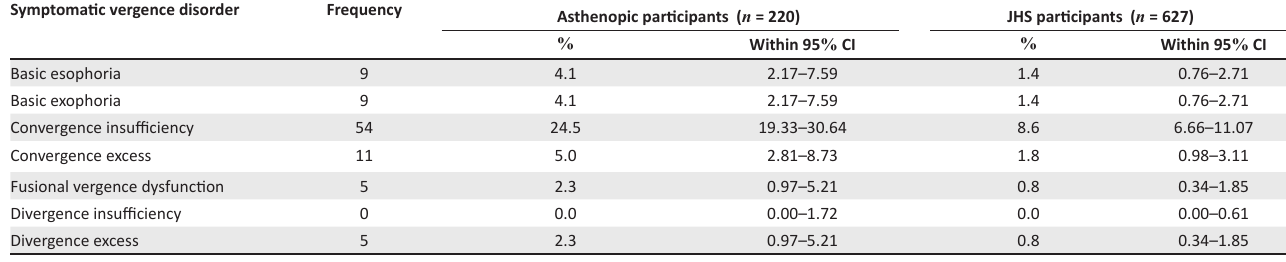
TABLE 1: Prevalence of specific symptomatic vergence disorders among Ghanaian junior high school students. Symptomatic vergence disorder